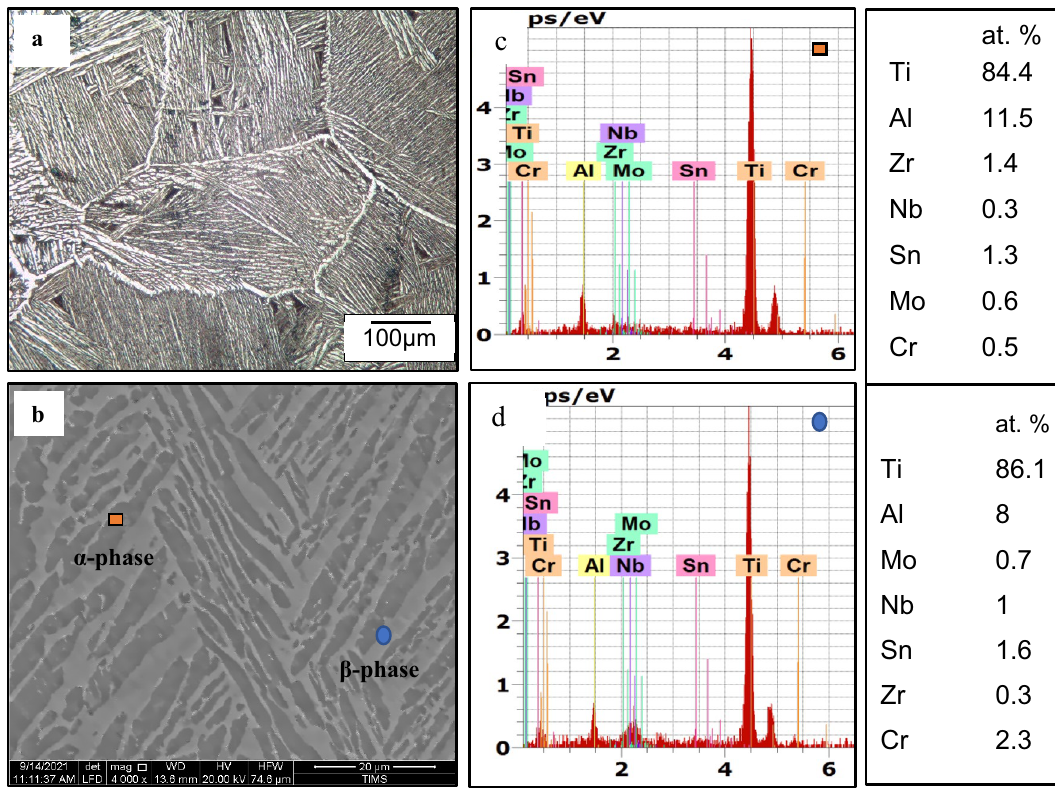
Figure 2. Lamellar microstructure of TC21 Ti-alloy: ( a ) OM ( b ) SEM and ( c ) EDS analysis for α-phase; ( d ) for β-phase.